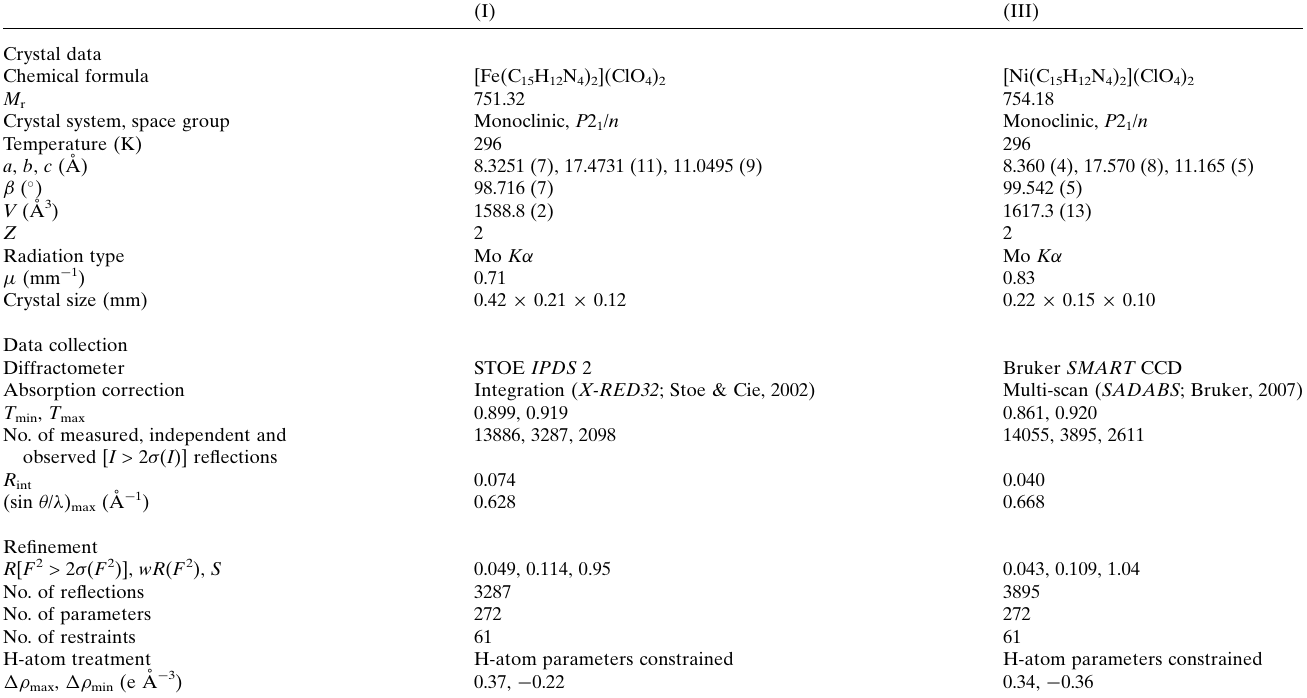
Crystal data Chemical